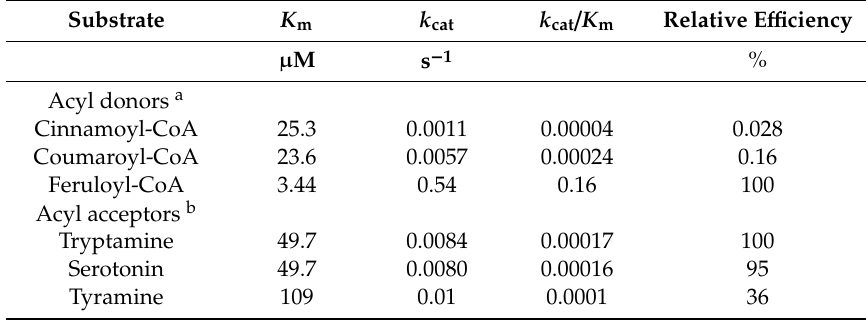
Table 3. Kinetic parameters of